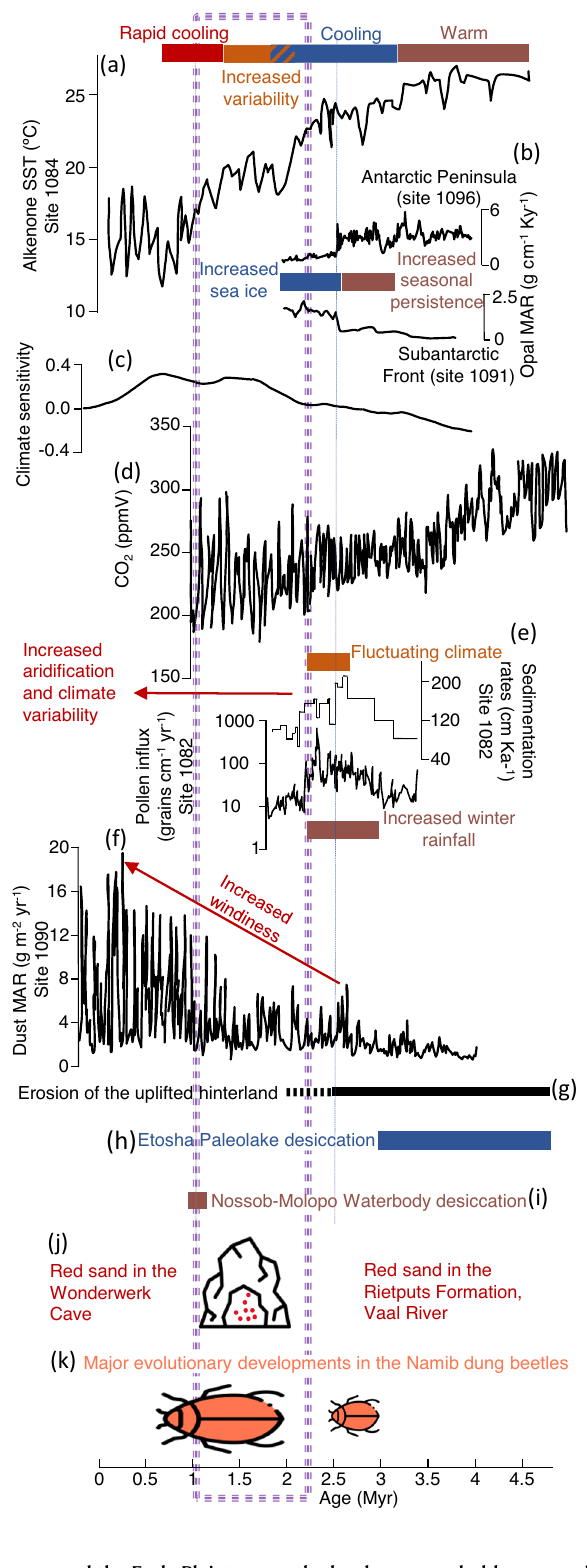
Fig. 3 | Environmental framework for the generation of the Kalahari Erg. The timing of initialsand introduction in the Kalahari Desert (purple dashed rectangle) isdisplayedontopofenvironmentalsettingsandkeyeventsinsouthernAfricaand proximate oceans. The text provides interpretation from previous studies of the records and is colored in accordance with colored bars and arrows. a Sea Surface Temperature(SST)recordoffshoreNamibia(ODPsite1084)derivedfromalkenone unsaturated index ( U K 0 37 ), which re fl ects the strengthening of upwelling along the west African margins throughout the Pleistocene 10 . b Primary productivity based on biogenic opal Mass Accumulation Rates (MAR) shows a coeval increase in the Southern Ocean (ODP site 1091) and decrease in the Antarctic Peninsula (ODP site 1096) due to theonset ofAntarcticSea Ice 49 . c Climate sensitivityin highlatitudes, calculated as the ratio between the deconvoluted records of the obliquity com- ponent of the scaled oxygen isotope and the solar forcing 47 . d Reconstructed atmospheric CO 2 record showing a decrease below the bioclimatic threshold for the expansion of C 4 plants at ~2.7Ma 54 . e Sedimentation rates and pollen In fl ux at ODP Site 1082 indicate a transition from a mixed fl uvial and eolian input to predominantly eolian transport at 2.2Ma 57 . f Dust MAR at site 1090 derived from Ti MAR recording increased windiness since ~2.7Ma 48 . g The southern Kalahari is breached by the erosive power of the Molopo following uplift in the range of hundreds of meters 24 . h The vast northern Kalahari Etosha paleolake is fi lled with sand 32 . i The Nossob-Molopo Waterbody is fi lled with gravel 30 . j The Wonder- werkCaveinthesouthernKalaharirimis fi lledwithsandaswellasredsandisfound in the Rietputs Formation in the Vaal River 33,34,59 . (k) Risen of new subgenus due to environmental stress in the Namib ~2 Ma 63 . Beetle and cave icons were made by Freepik from www. fl